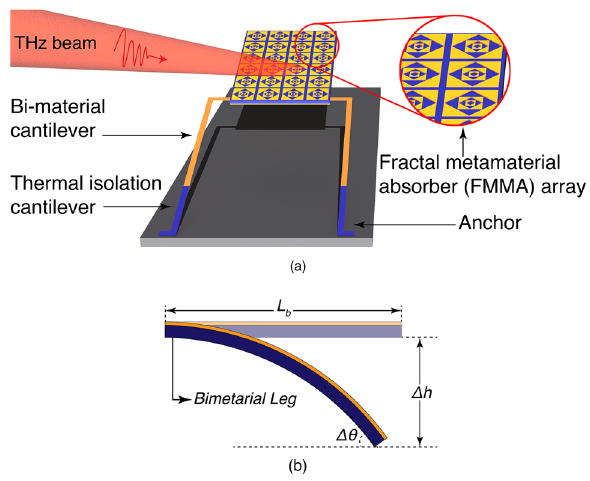
Figure 2. FMMA based sensing pixel ( a ) 3D view. ( b ) Illustration of thermomechanical deflection of the bimaterial sensor. The figure was created using Adobe Photoshop CC 2022 (Version 23.4.1, https:// www. adobe. com/ produ cts/ photo